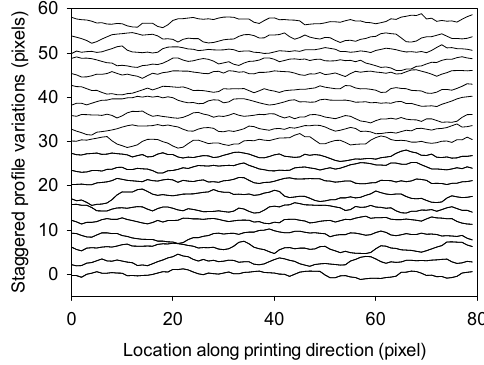
Figure 6. Twenty sampled realizations from the estimated Gaussian process model.